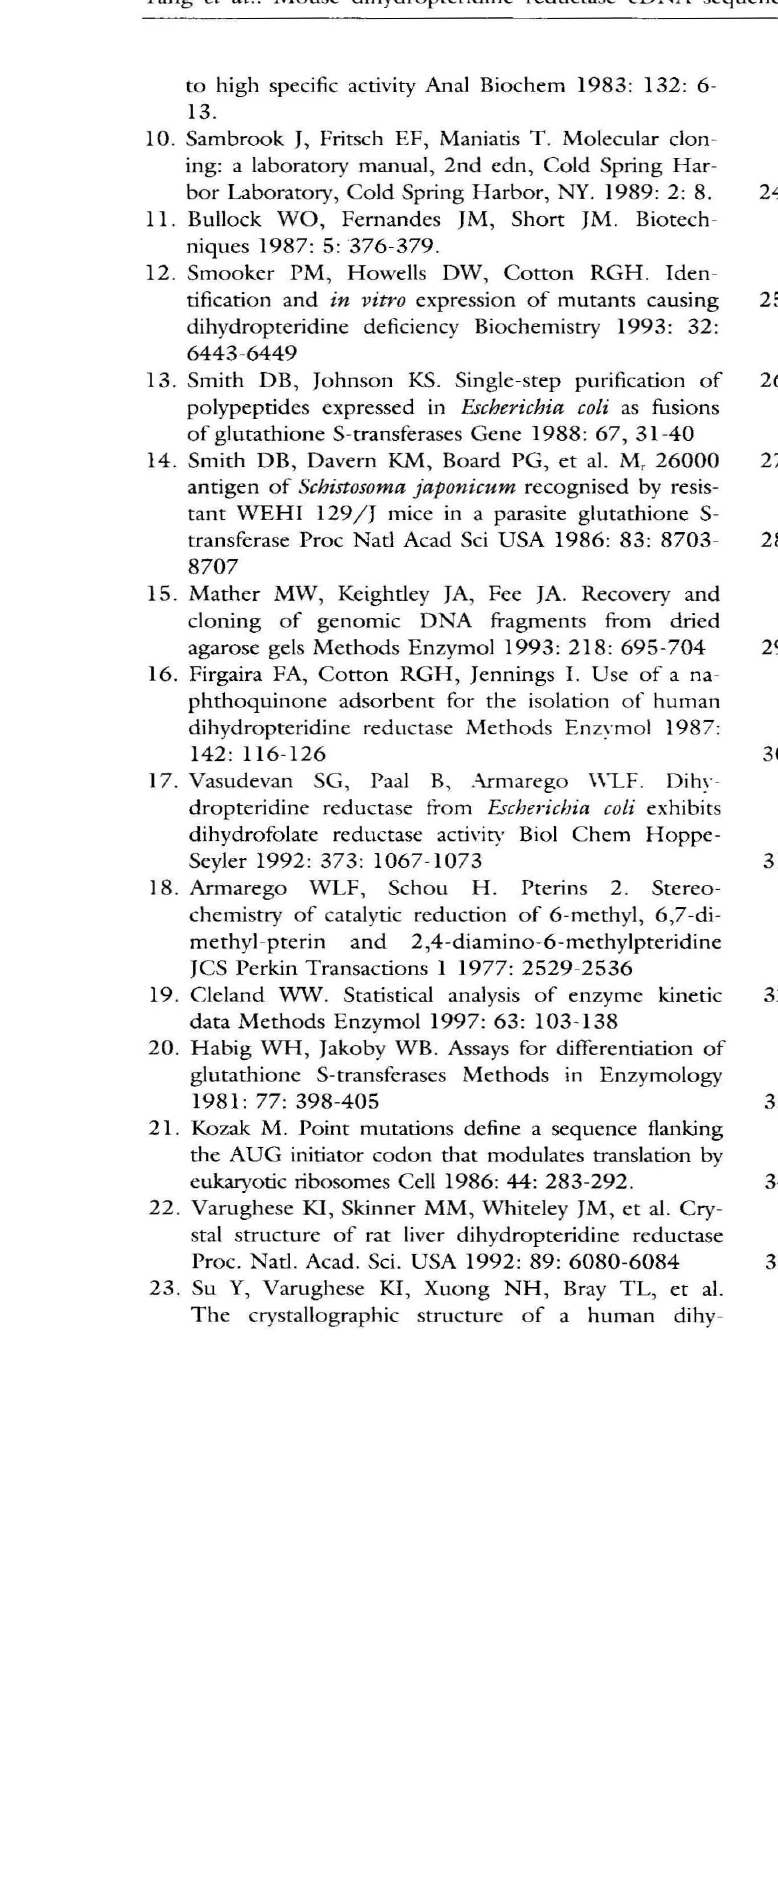
Yang et al.: Mouse dihydropteridine reductase cDNA sequence and comparison